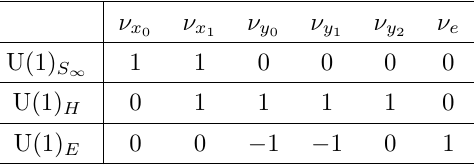
Table 4 . GLSM charges of the toric coordinates of the base B 3 , obtained by blowing up the P 1 -(cid:12)bered three-fold H P 1 1 along its (cid:12)ber